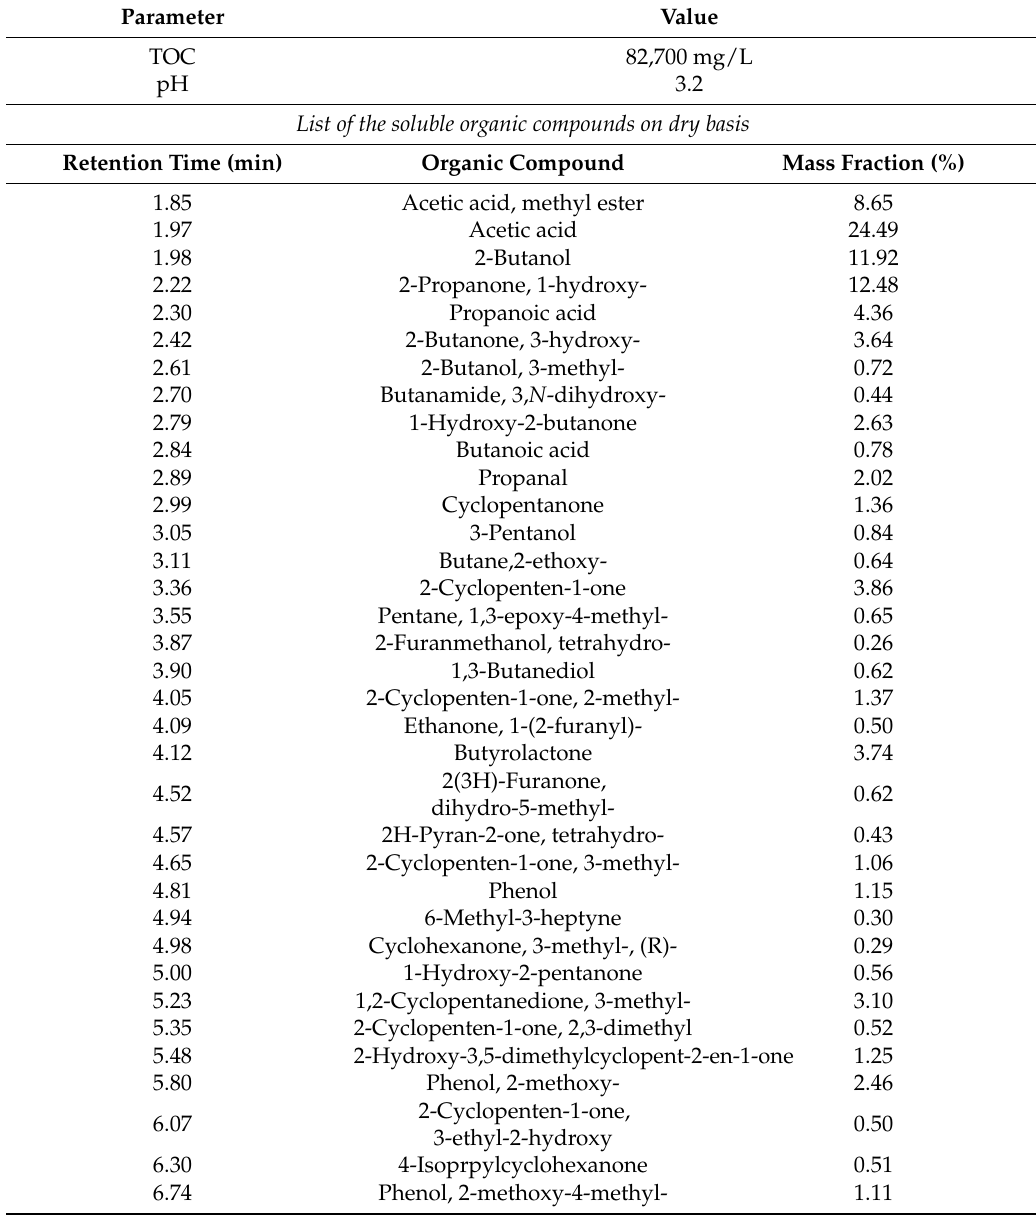
Table 1. Main physicochemical characteristic of the aqueous phase. Parameter Value TOC 82,700 mg/L pH 3.2 List of the soluble organic compounds on dry basis Retention Time (min) Organic